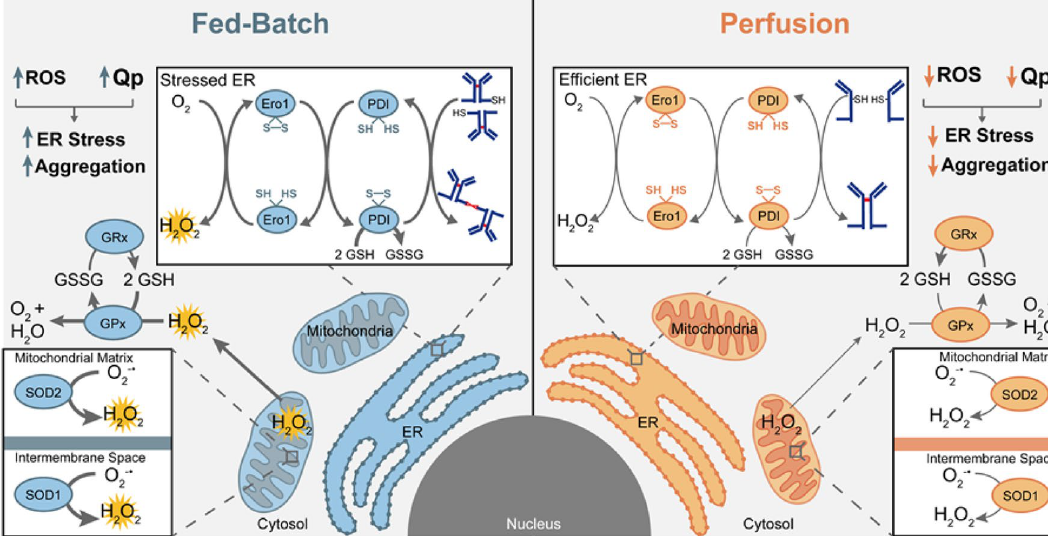
Figure 7. Schematic representation of the intracellular mechanisms underlying BisAb aggregation in a CHO cell process. Intracellular mechanistic differences between a fed-batch (Left) and a perfusion process (Right) are depicted. Left Panel: Reactive oxygen species (ROS) accumulation, caused by higher specific productivity (Qp) and oxidative damage, impairs intracellular glutathione regulation and disrupts ER homeostasis, leading to higher BisAb aggregation. Right Panel: Mitigation of intracellular ROS accumulation alleviate glutathione oxidation and improve reduced to oxidized glutathione ratio. Efficient intracellular glutathione regulation and lower Qp in a perfusion process protect CHO cells against ER stress and mitigates BisAb aggregation. This schematic illustration was made with Adobe Illustrator 23.0 software (https ://www.adobe .com/produ cts/illus trato